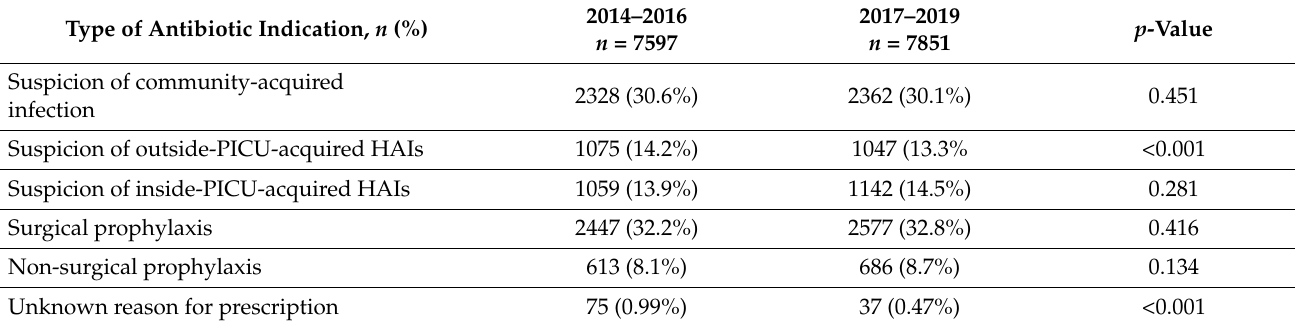
otic use ratio, antibiotic-free days ratio, and global antibiotic-free days